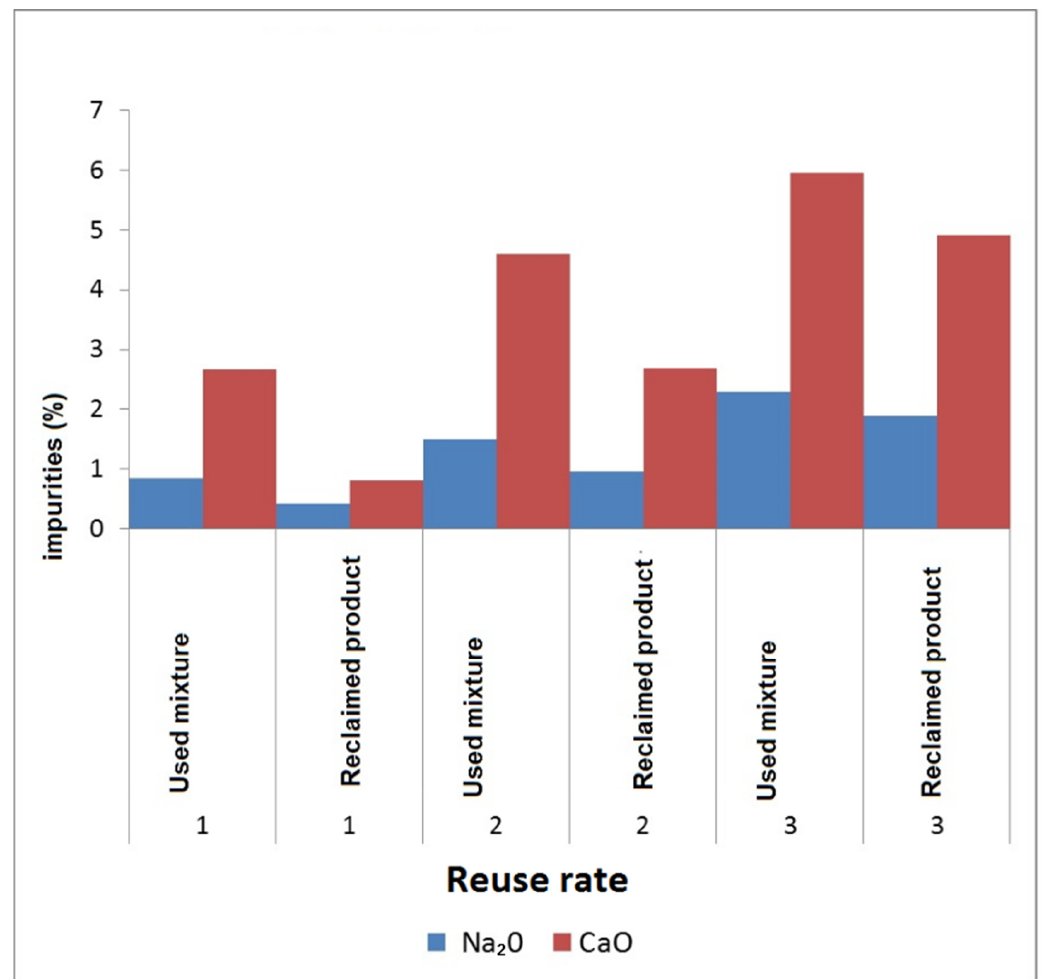
Figure 2. Properties of used liquid glass mixtures.